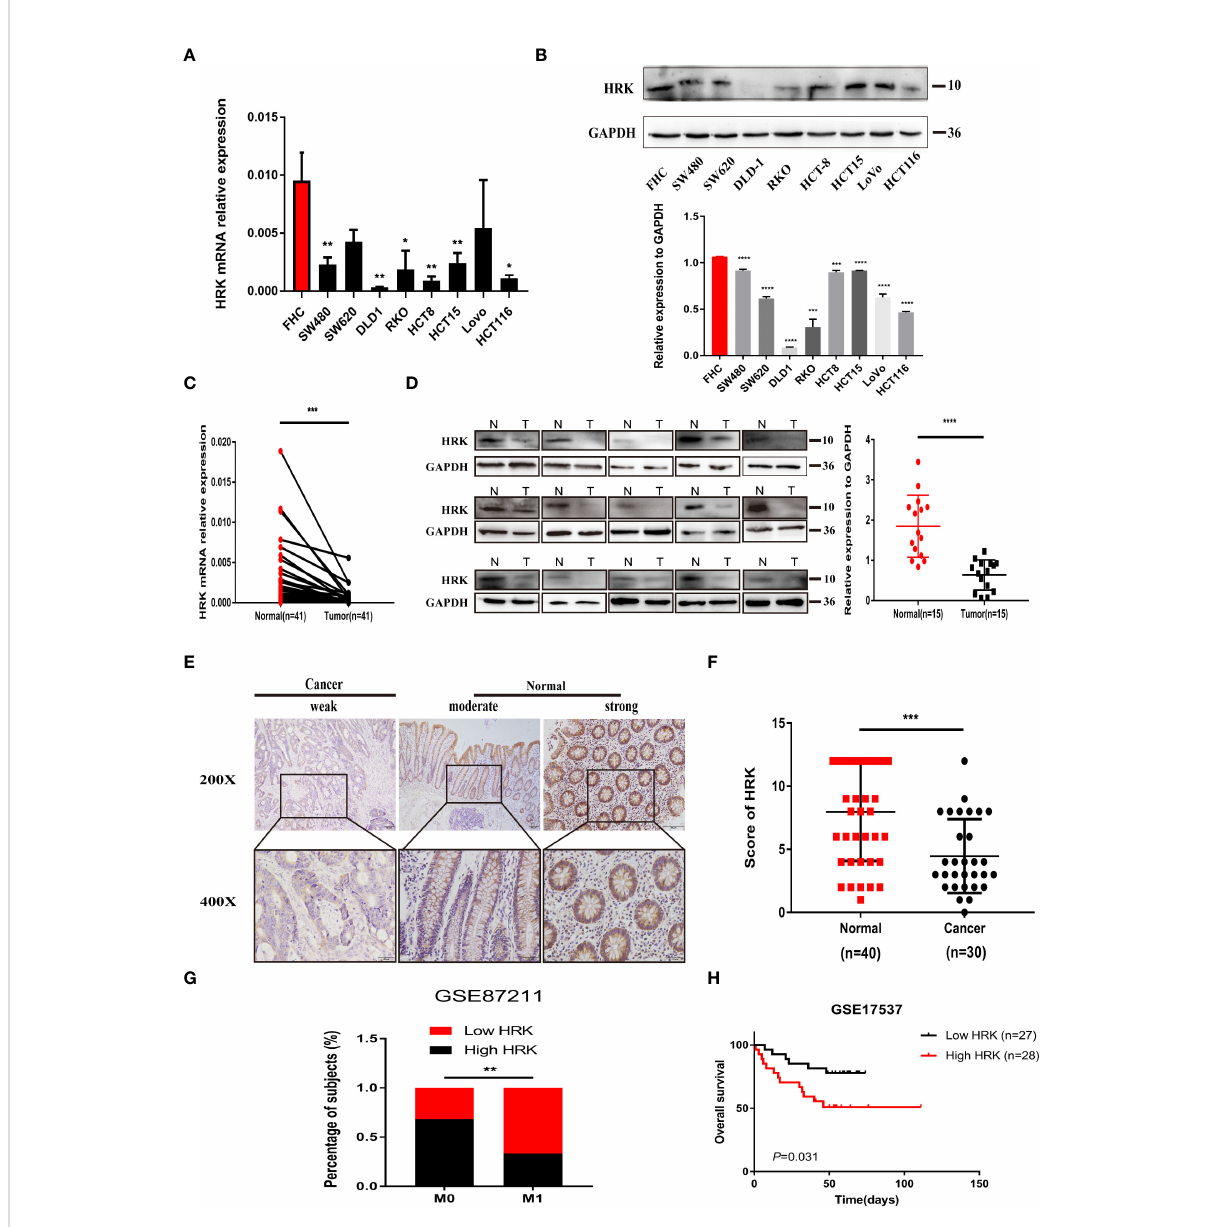
FIGURE 2 HRK is downregulated in CRC and likely predicted good prognosis in CRC patients. (A, B) , Expression levels of HRK mRNA (A) and protein (B) in CRC and colon mucosa epithelial cell lines. (C, D) , Expression levels of HRK mRNA (C) and protein (D) in paired CRC and adjacent noncancerous tissues (N: Normal, T: Tumor). (E) , Expression analysis of HRK protein in CRC and normal colorectal mucosa tissues by IHC. Scale bars, 50 m m (×200 magni fi cation) or 20 m m (×400 magni fi cation). (F) , Distribution of HRK expression in cancerous and normal tissues in IHC. (G) , Percentage of high and low expression of HRK with different distal metastasis in the database GSE87211 (M0: the patient has no distant metastasis, M1: metastasis to one or more distant sites or organs, or peritoneal metastasis is con fi rmed). (H) , Kaplan – Meier survival analysis of in database GSE17537 with low and high expression of HRK. Data information: Graphs report mean ± SEM. Signi fi cance was assessed using two- tailed Student ’ s t test, except for G where Chi-square test was used and H where log-rank test was used. *P < 0.05, **P <0.01, ***P < 0.001 and ****P <